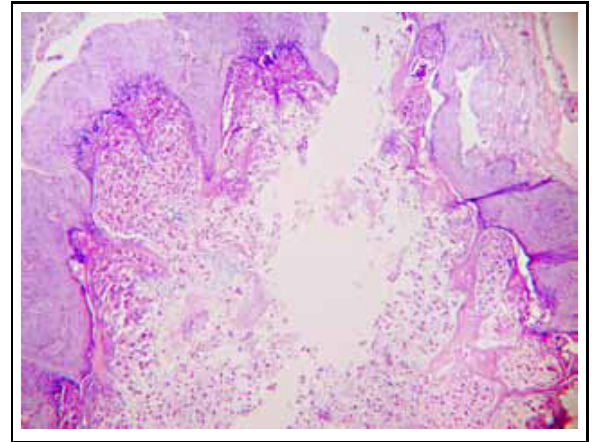
Figure 2(b). Unilocular epidermoid cyst with crateri - form lesions lined by hyperplastic squamous epithe - lium (H and E, ×40).